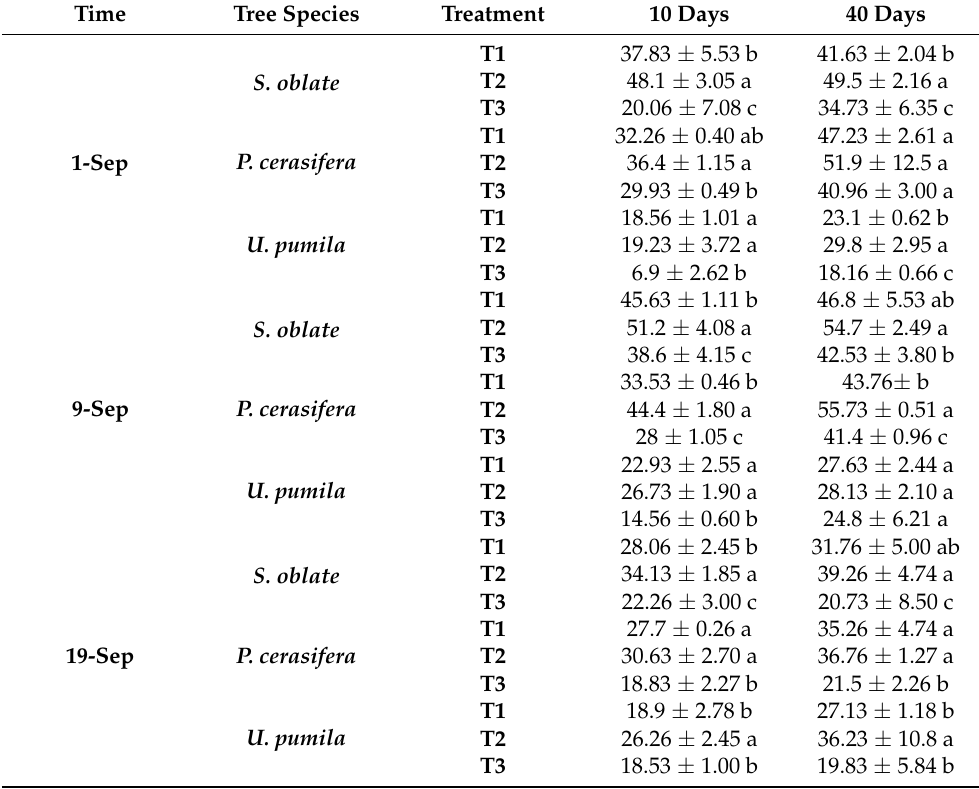
Table 3. Leaf chlorophyll SPAD for three different SO 2 treatments (T1–T3) on 1 September, 9 Septem- ber, and 19 September 2019 for S. oblate, P. cerasifera and U. pumila. Bars sharing a common letter are not significantly different ( p < 0.05). Bars represent means ± SE ( n = 9). Time Tree